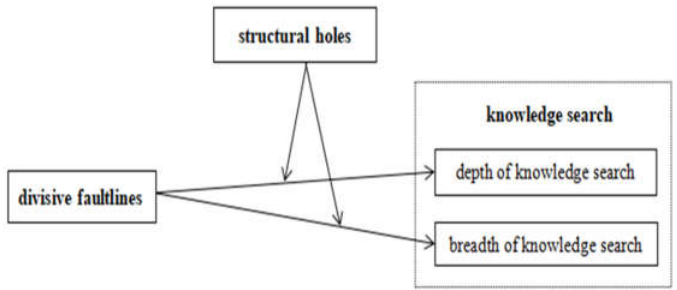
Figure 1. The theoretical